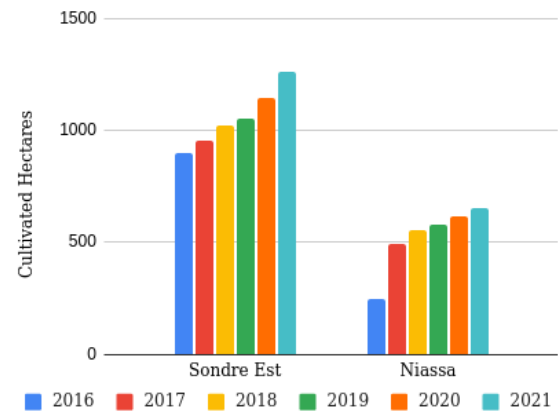
Figure 7: Total cropland within the boundaries of each reserve from 2016 to 2021 Figure 8 identifies cropland expansion in Sondre Est. The